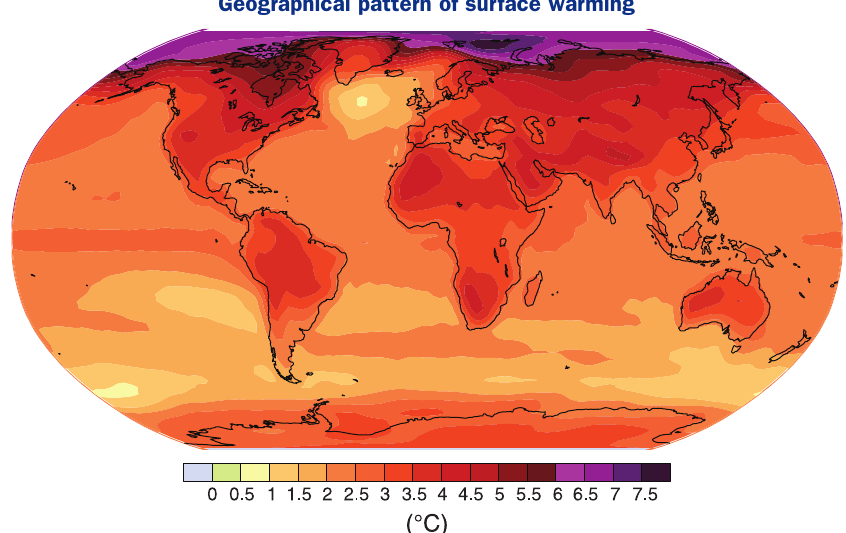
Figure SPM.6. Projected surface temperature changes for the late 21 st century (2090-2099). The map shows the multi-AOGCM average projec- tion for the A1B SRES scenario. Temperatures are relative to the period 1980-1999. {Figure 3.2}